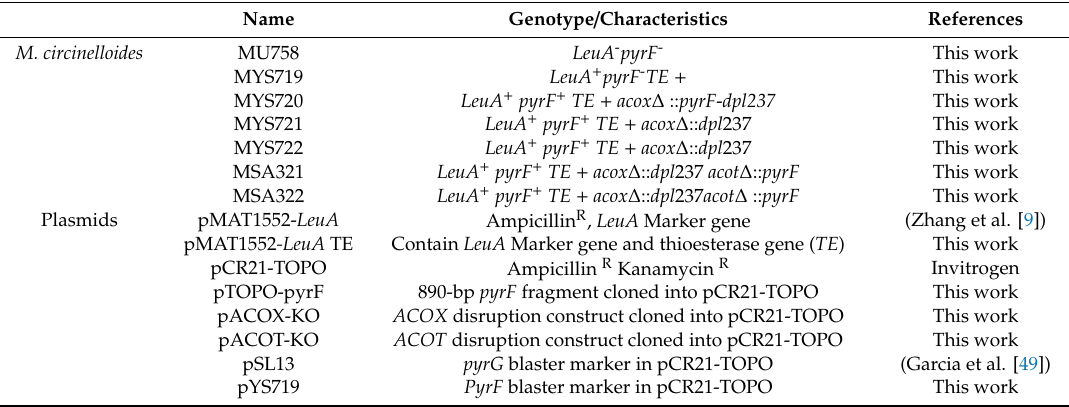
Table 1. List of strains and plasmid used in this